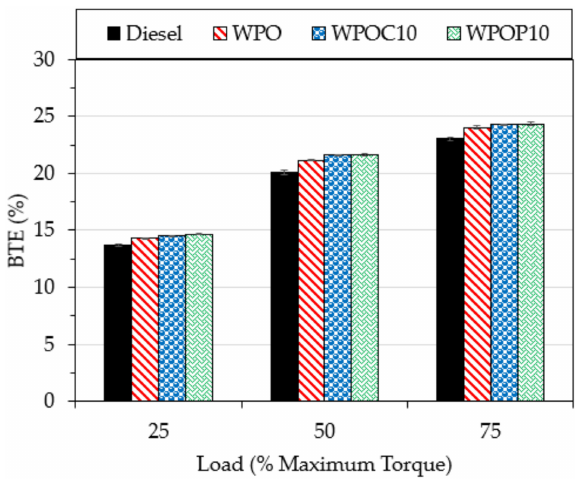
Figure 6. Variation of the brake thermal e ffi ciency.